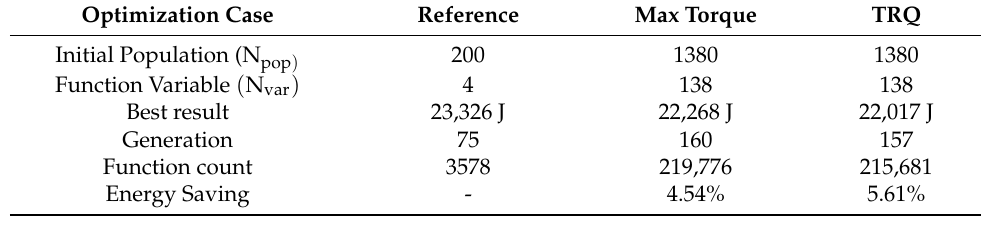
Table 4. Optimization parameters and results for London Track.